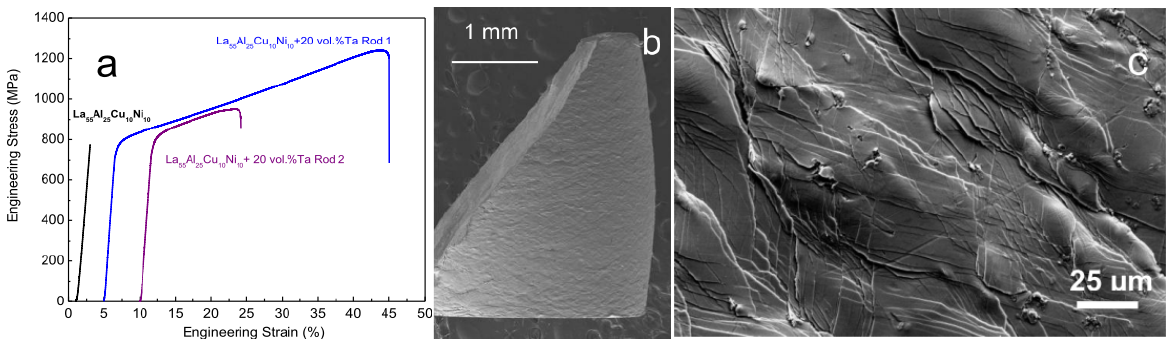
Figure 3. ( a ) Compressive stress-strain curves for the monolithic La metallic glasses (BMG) and the Ta-reinforced glassy composite, showing the enormous increase in plasticity. ( b ) Shear failure in the composite specimen. ( c ) Shear band proliferation is seen on the sides of the compressive